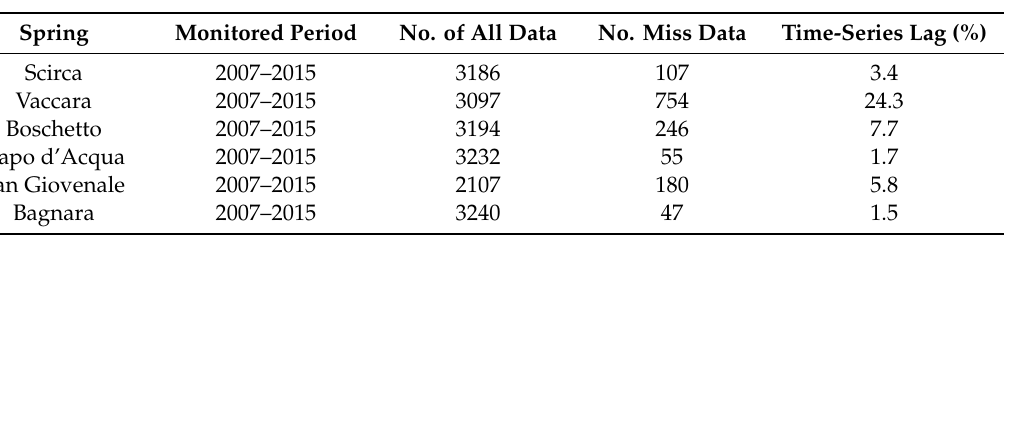
Table 3. General characteristics of the time-series of the analyzed aquifer